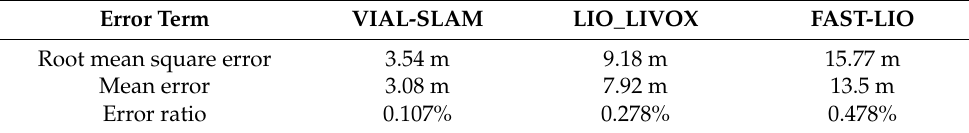
Table 2. The autonomous positioning test results in the urban road